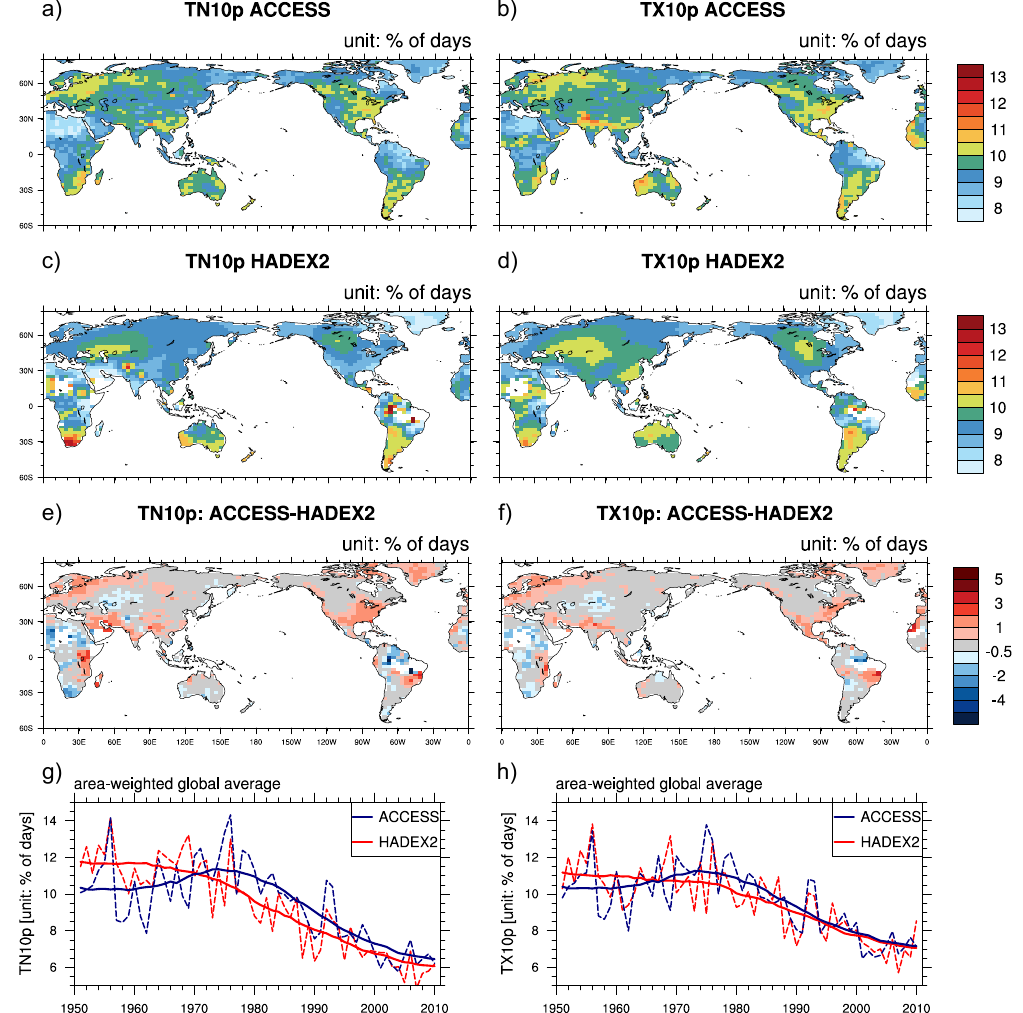
Fig. 4. Annual cool nights (TN10p, left column) and cool days (TX10p, right column) for ACCESS1.3b (a, b) , HadEX2 (c, d) , bias (e, f) and the global average time series showing trends (g, h) . Unshaded areas reflect missing observation data. ACCESS data were masked depending on the availability of HadEX2 before calculating the global average. We applied a static masked only including grid points where more than 50 years of data (out of 60) were available to calculate the global average. The solid lines in (g) and (h) show the time series smoothed by a 21-year Gaussian filer, while the dashed lines show the yearly